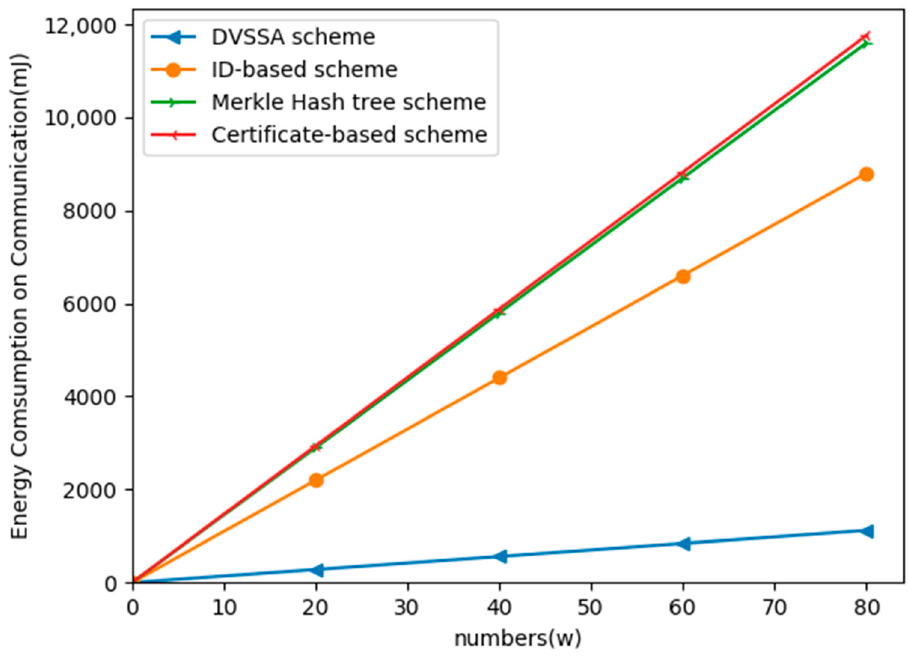
Figure 6. Energy consumption on communications with regard to the number of users.